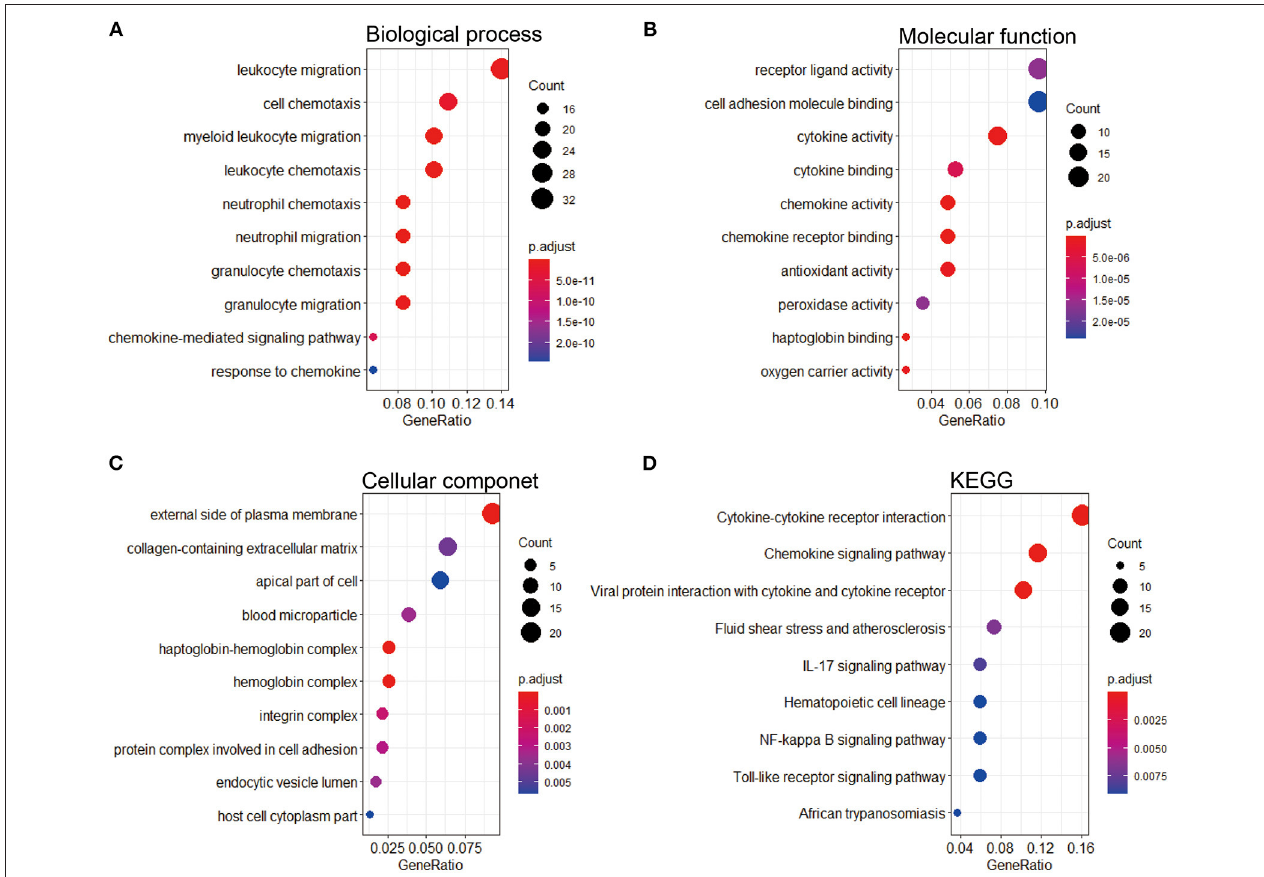
FIGURE 3 | GO and KEGG pathway enrichment of the robust DEGs in IPAH. (A) Top 10 biological processes. (B) Top 10 molecular functions. (C) Top 10 cellular components. (D) Top 10 of the KEGG pathway. GO, Gene Ontology; KEGG, Kyoto Encyclopedia of Genes and Genomes; DEG, differentially expressed gene; IPAH, idiopathic pulmonary arterial